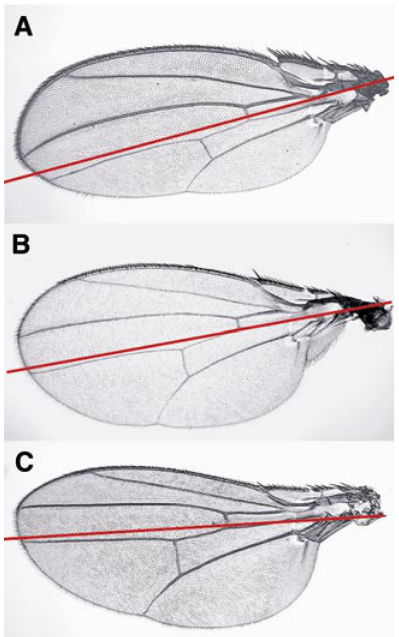
Figure 1. The Insulin Signaling Activity Controls Organ Size in a Compartment-Specific Manner Mosaic Drosophila wings with compartment-specific manipulations of dAkt function display striking size defects but normal patterning. (A) Selective reduction of dAkt function in the posterior compartment by means of FLP-mediated mitotic recombination in posterior cells (using engrailed–Gal4 to drive the expression of UAS–Flp ) results in a small P compartment largely consisting of dAkt 3 mutant cells. The smaller compartment size is due to fewer and smaller cells. (B) Wild-type wing for comparison. (C) Expression of dAkt in posterior cells ( engrailed–Gal4 UAS–dAkt ) of wings with reduced dAkt function ( dAkt 3 ) restores the size of the P compartment, whereas the A compartment remains small. The red lines mark the anterior–posterior compartment boundary. Note that similar results in the wing disc have been obtained by Teleman and Cohen